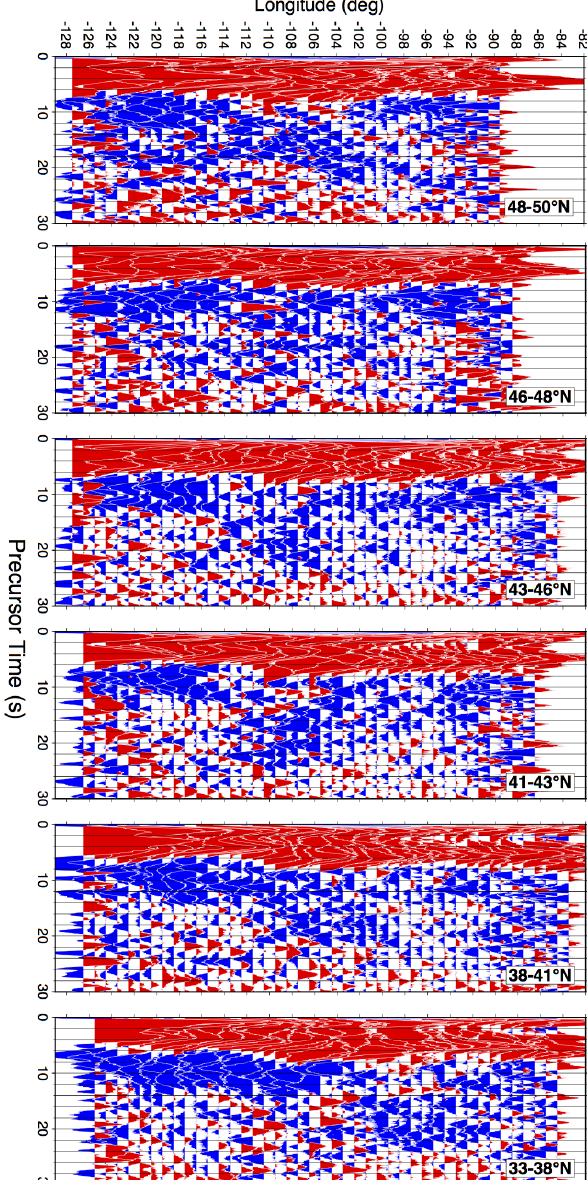
Figure 11. The same profiles as in Fig. 10 but with no filter applied.